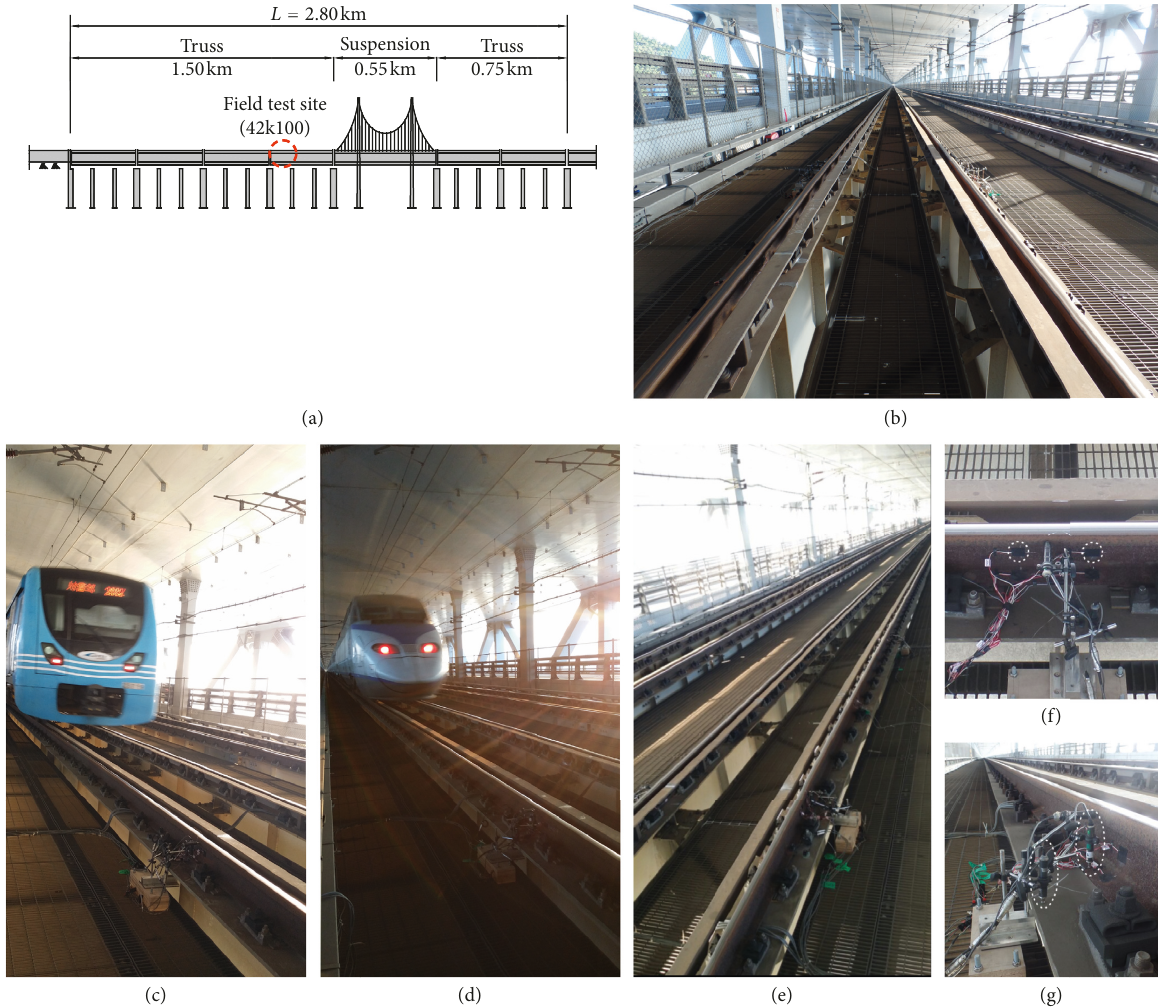
Figure 3: (a) Location of the measurement; (b–g) vertical rail and track girder displacements measured using displacement transducers mounted on a jig anchored at the side bridge inspection passage, where it was not affected by the passing train. Table 2: Properties of the tested train. AREX AREX Express